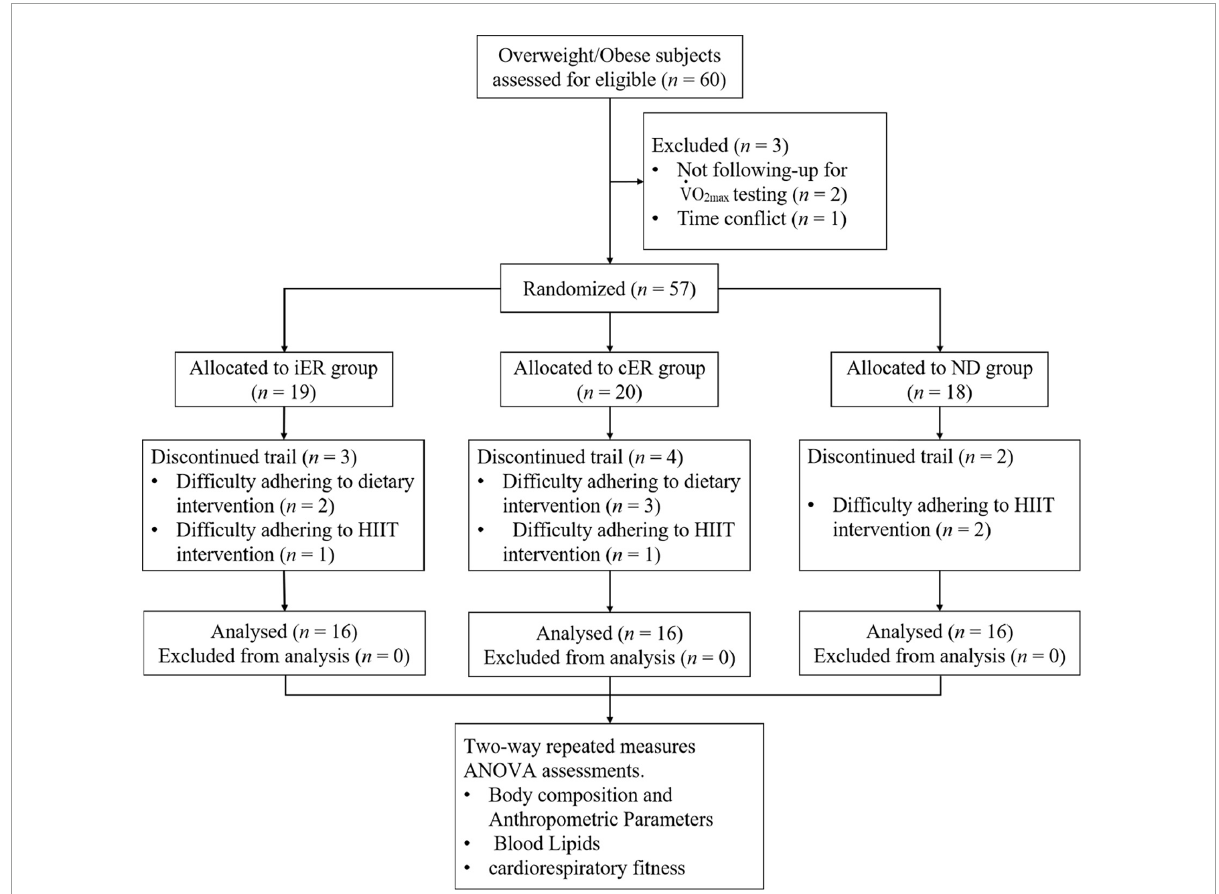
FIGURE1 Consort flow diagram. This figure illustrates the number of participants from enrollment to completion of the trial. A total of 60 overweight/obese subjects were deemed eligible and consented to partake in the study. Two participants dropped out due to not followed ˙VO 2 max testing, and 1 participant had a time conflict with exercise training. After completing the baseline period, participants were randomized to an iER group ( n = 19), a cER group ( n = 20), or a ND group ( n = 18). During the 4-week intervention, nine participants removed themselves from the study due to could not adhere to dietary intervention or HIIT intervention, but none discontinued due to adverse events. Thus, totally 48 participants ( n = 16 in each group) completed the